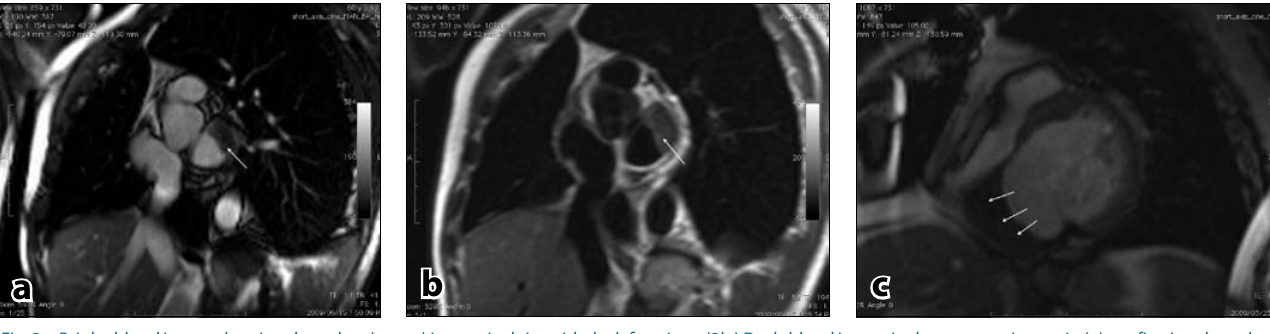
Fig. 2a. Bright-blood image showing thrombus (arrow) in a typical site with the left atrium. (2b.) Dark-blood image in the same patient as in (a) confirming thrombus (arrow) within the left atrium. CMR was used in this case following equivocal echocardiography for confirmation of thrombus and to differentiate this from an atrial myxoma. (2c.) Extensive mural thrombus (arrows) is shown in a patient with previous infero-septal myocardial infarction with aneurysm